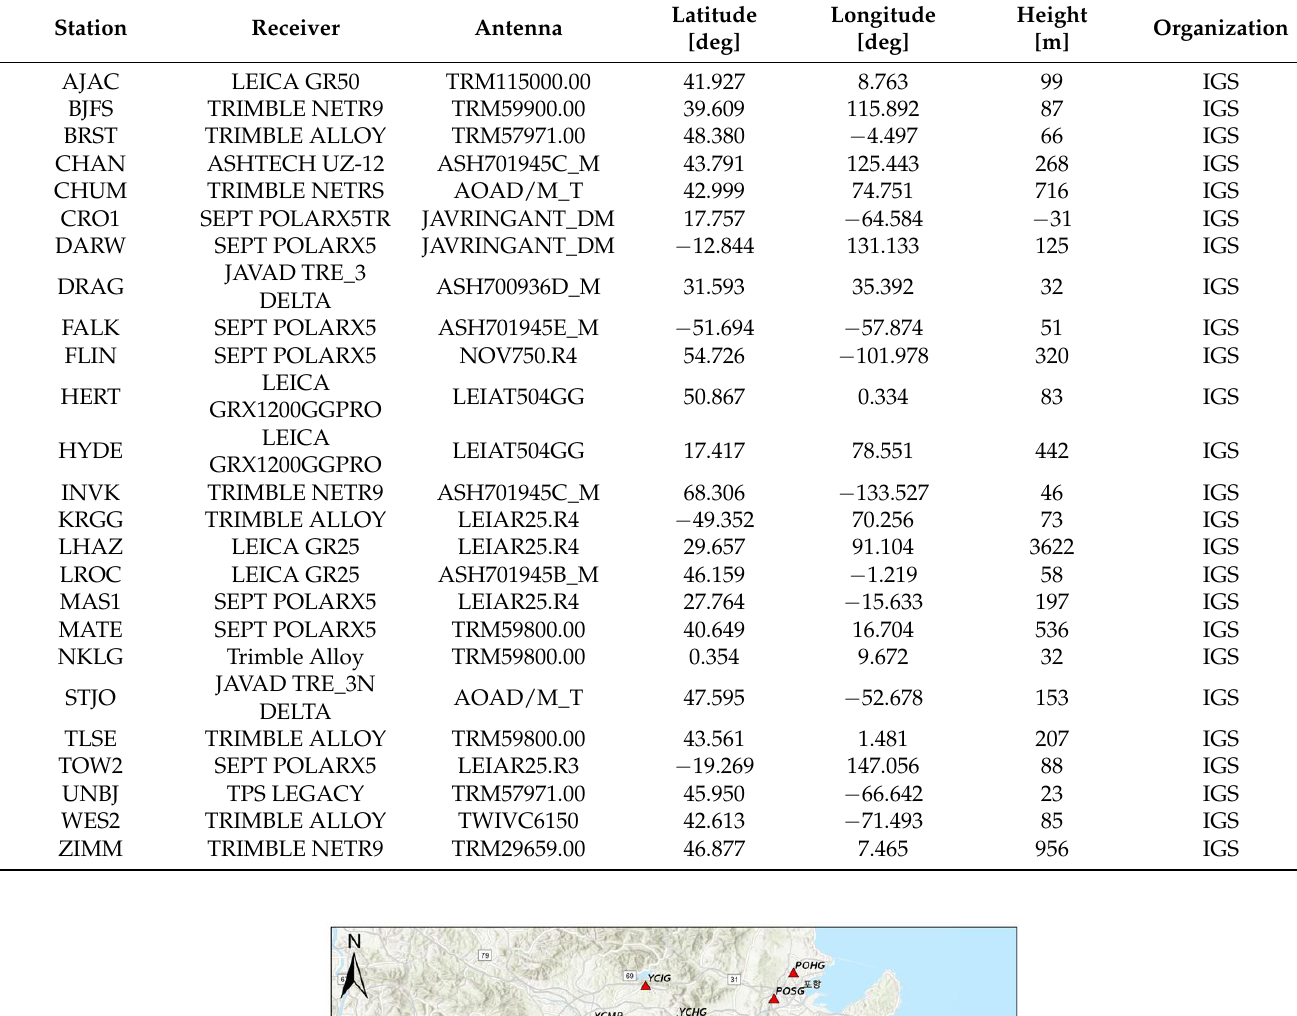
Table 2. The list of IGS stations.